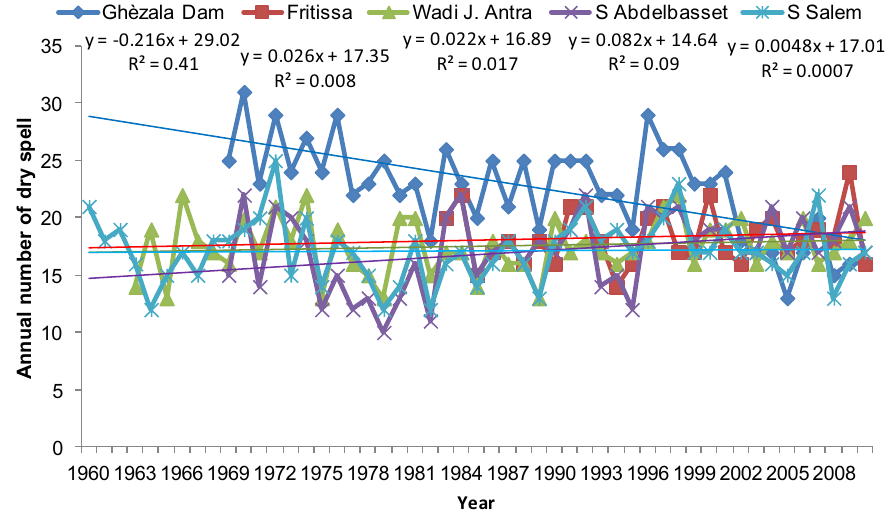
Fig. 6 Tends of annual number of drought affected stations in Ichkeul lake basin